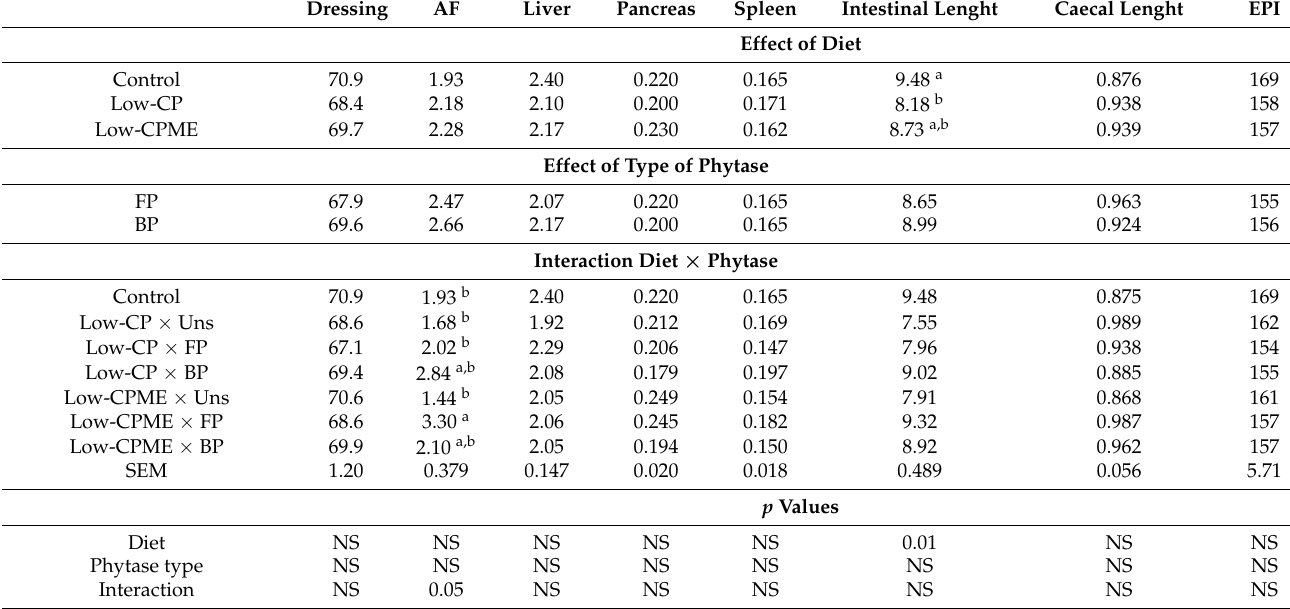
Table 4. Effect of diet, type of phytase, and their interaction on carcass traits and production index (%) of broilers.